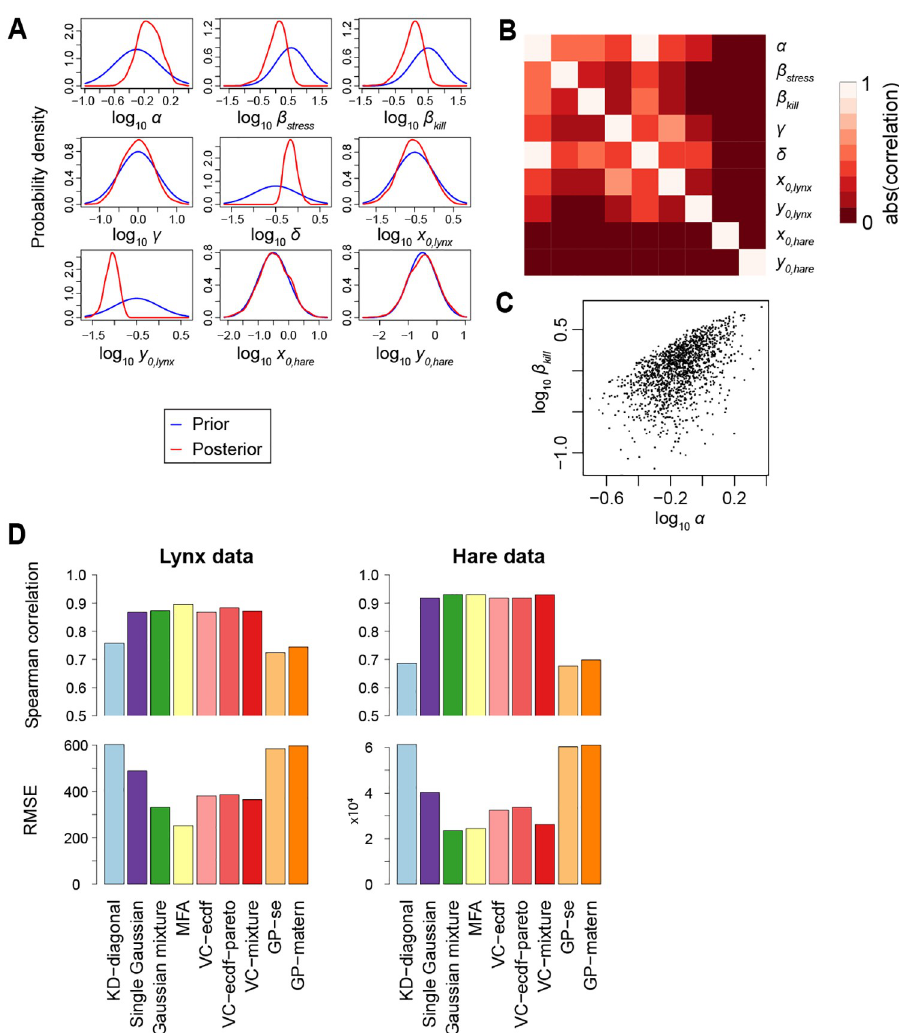
Fig 5. Lynx and hare dataset posterior approximation. (A) Marginal posterior densities after seeing the lynx data, the graphs are constructed using kernel density estimation with plug-in bandwidth selection. (B) Correlations between the parameters in the lynx posterior. (C) Scatter plot of the samples for one parameter combination. (D) Approximation accuracy as a function of sample size. Spearman correlation and root mean square error were calculated by comparing the approximation with another 1,000 MCMC samples from the